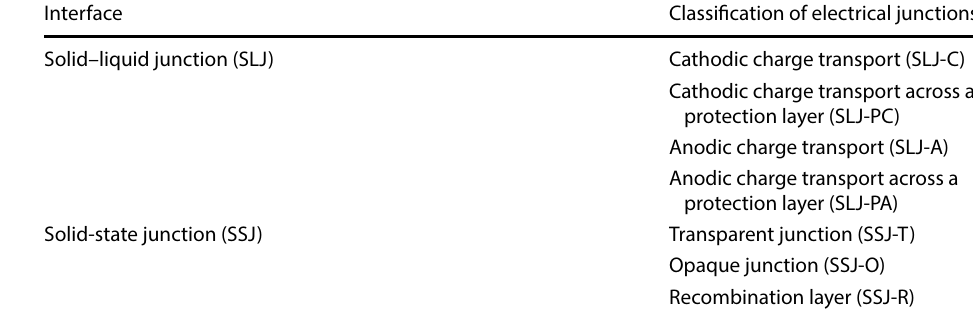
Table 1 Classification of electrical junctions on a PV cell in PEC devices